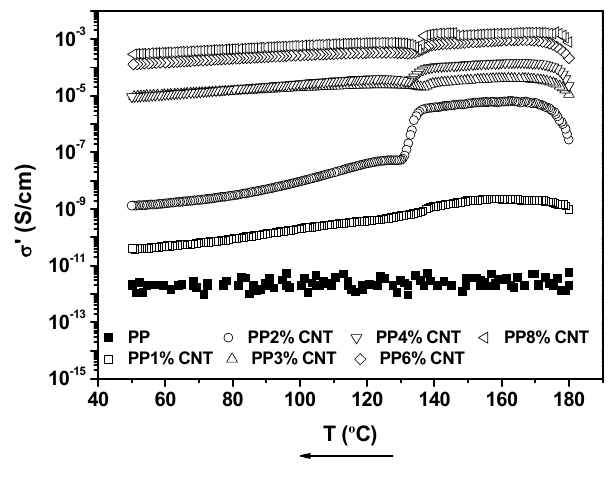
Figure 8. Electrical conductivity (DC) of MWCNT/PP nanocomposites during the cooling sweep from 180 °C up to 50 °C. The effect of temperature on the ionic conductivity of PP could not be adequately analyzed because of limitations of our